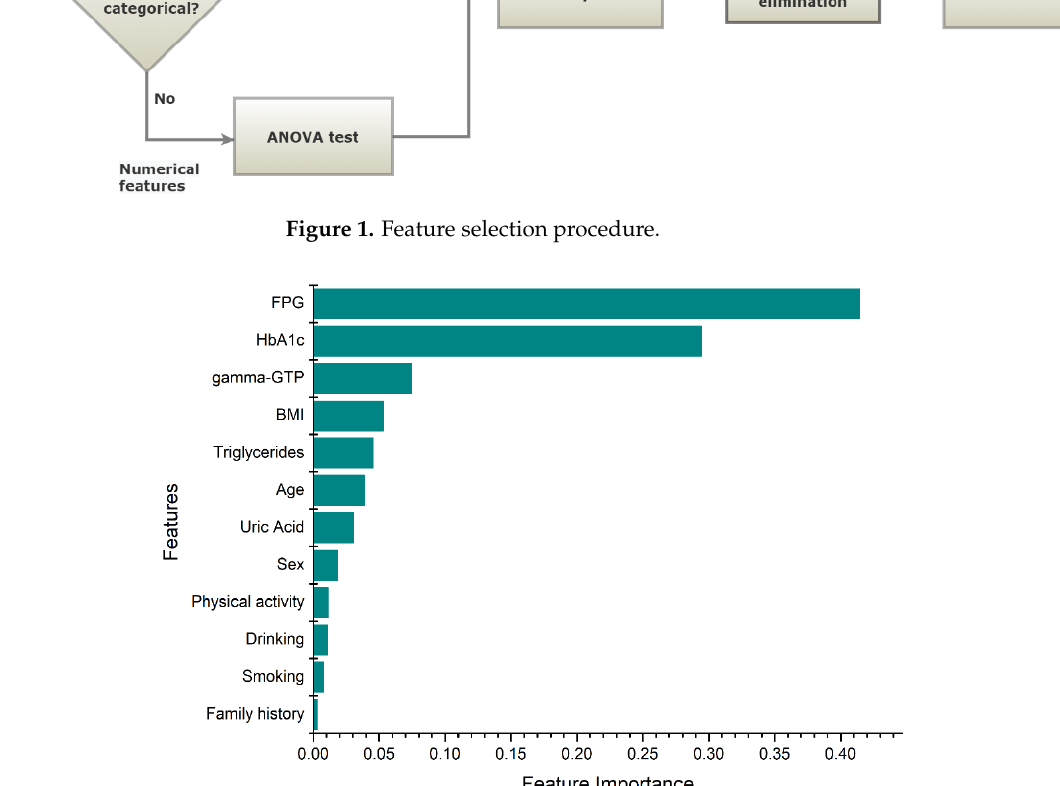
Figure 1. Feature selection procedure.